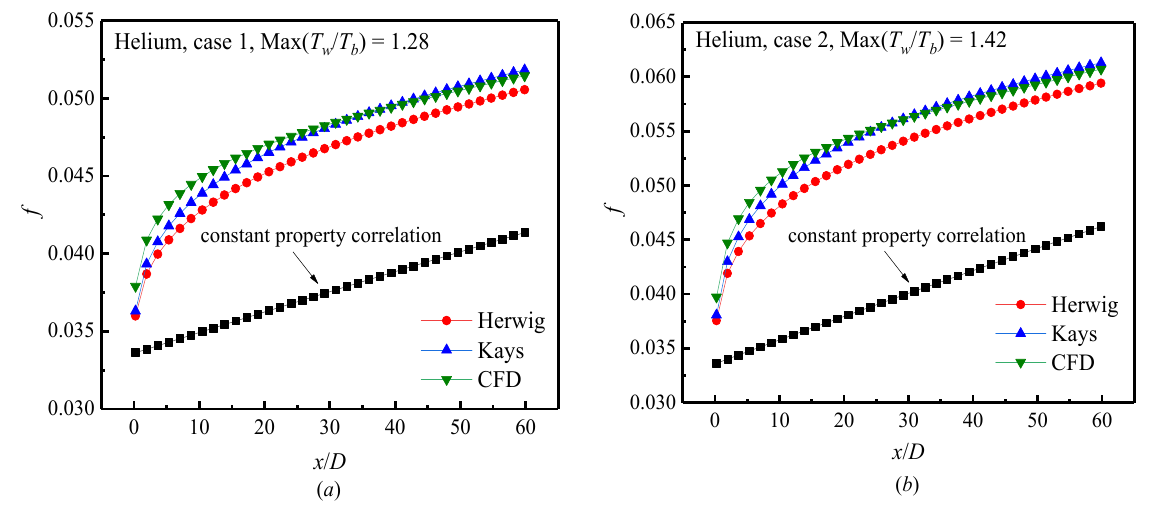
Figure 3. Calculations by existing f correlations for helium. ( a ) case 1; ( b ) case 2. As shown in Tables 4 and 5, the prediction errors of the three f correlations for helium